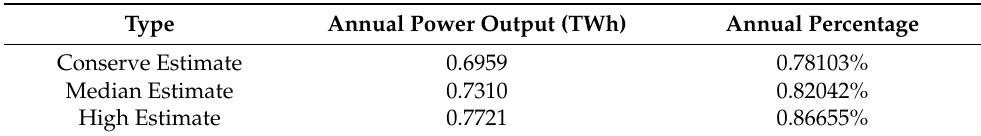
Table 5 . Regarding estimates of yearly power generation by potential Falls of Rough solar farm. Percentages are based off average annual electricity consumption in Kentucky [27,29].